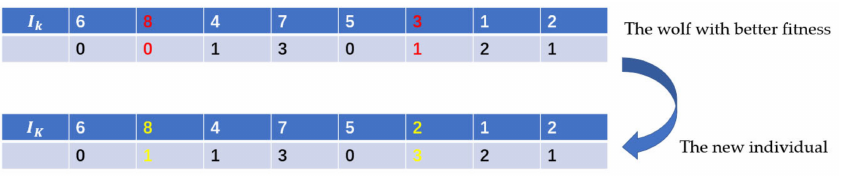
Figure 7. Generate new individuals in a mutated